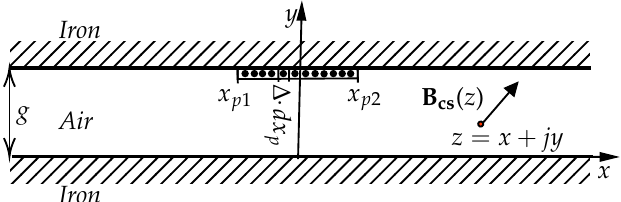
Figure 2. Horizontally oriented current sheet of length b cs , powered by a current density ∆ flowing outwards from the paper plane, whose extremes are situated at z p 1 and z p 2 between two smooth iron